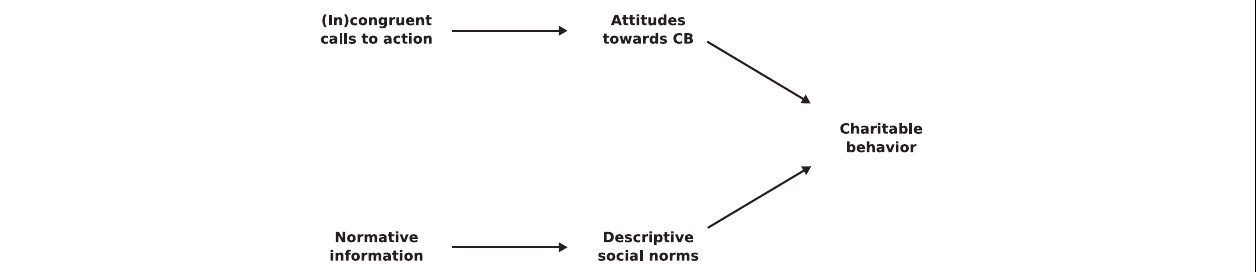
Frontiers in Psychology |